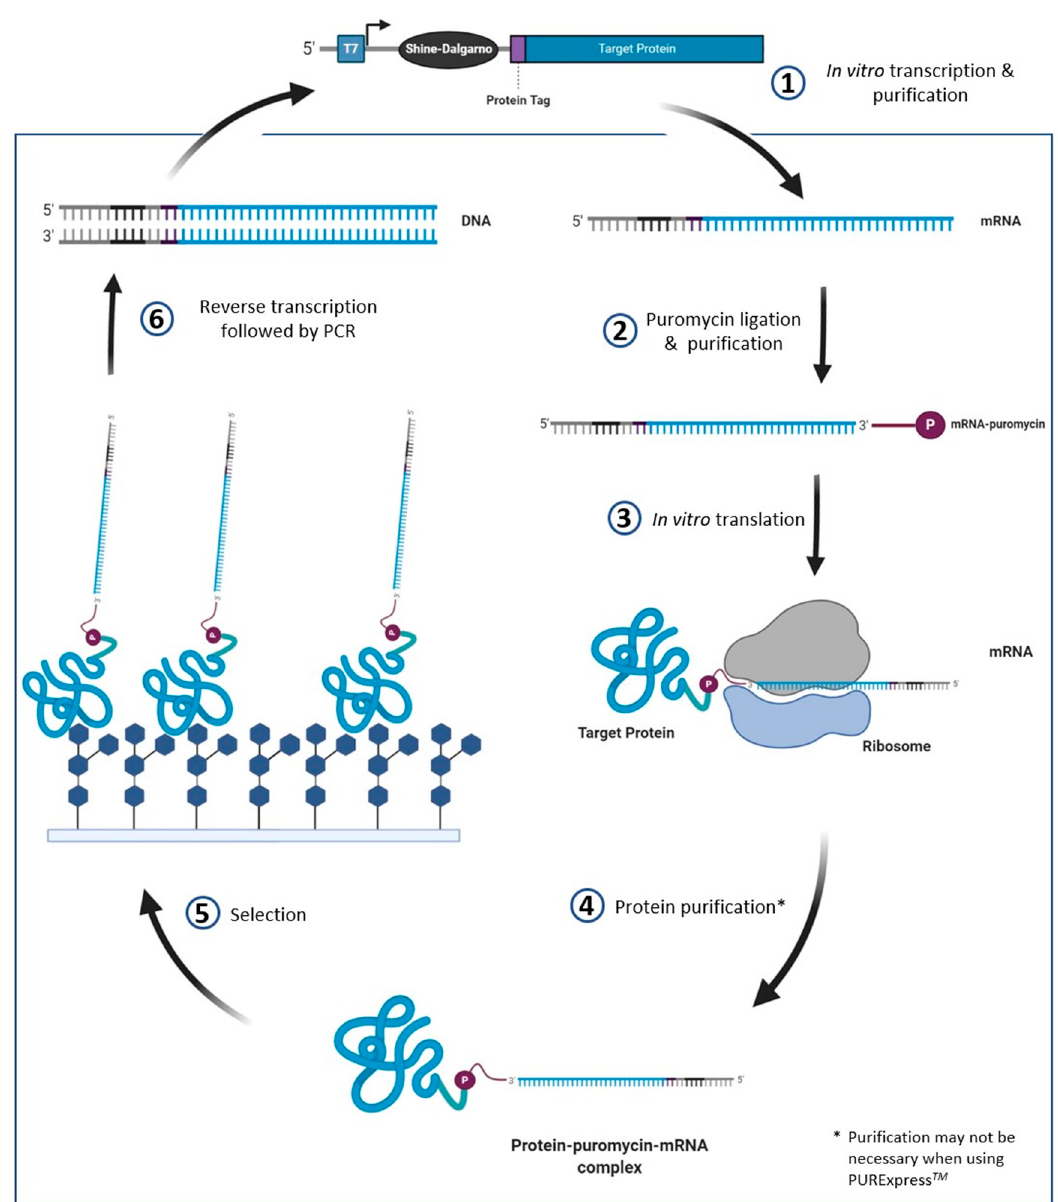
Figure 5. Overview of the mRNA display method. The initial construct design has to contain a promoter (e.g., T7) and RBS (e.g., Shine Dalgarno) specific to the cell free expression system used. The puromycin mimics an aminoacyl tRNA which causes the mRNA to be linked to the nascent protein during in vitro translation. Once translated, the mRNA-protein complex is screened for glycan binding. The mRNA attached to the bound proteins is reverse transcribed and PCR amplified—allowing for simplified sequence detection.